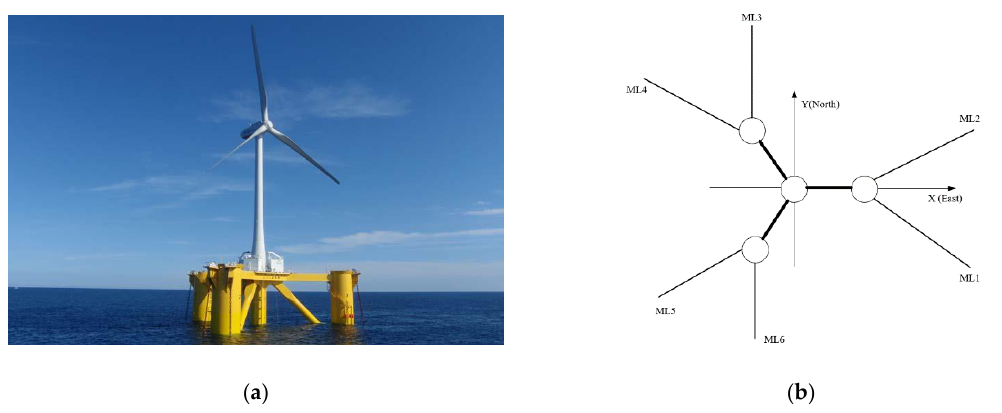
Figure 15. 2 MW semi-submersible FOWT used in the Fukushima demonstration project. ( a ) Overview of full-scale platform and ( b ) configuration of mooring lines.